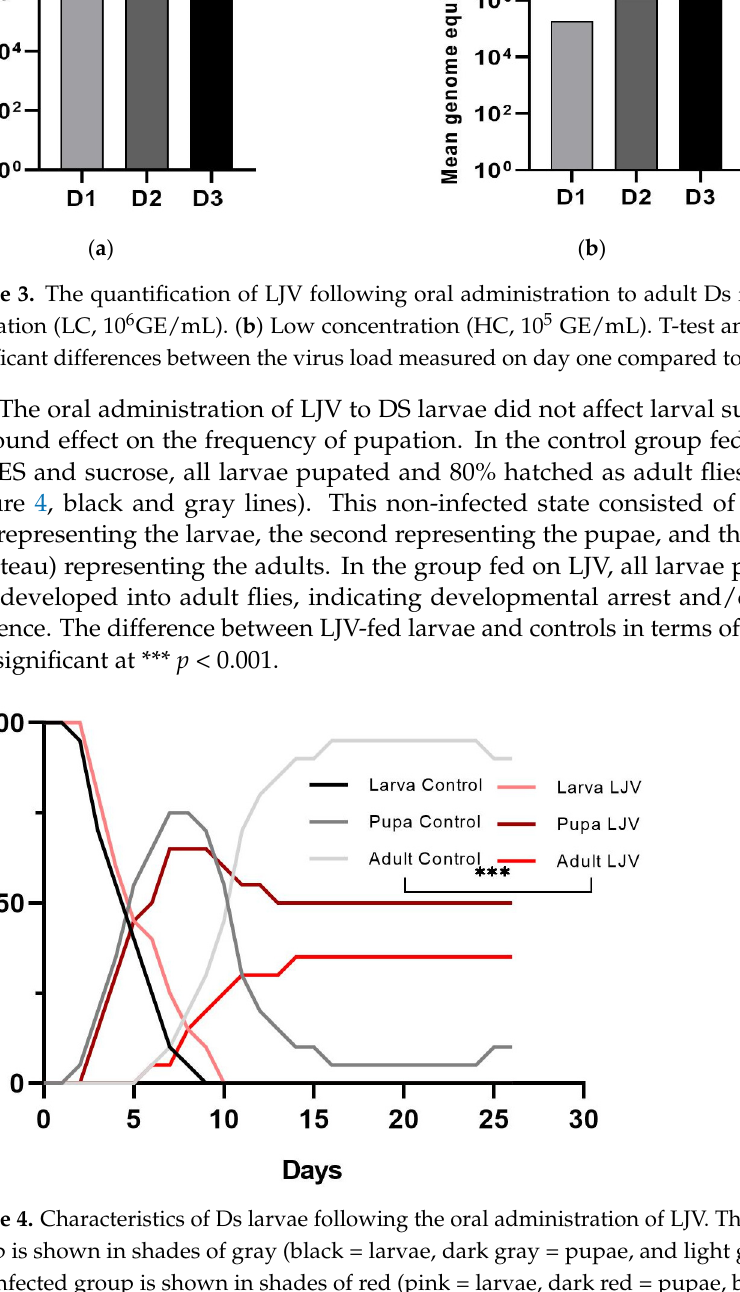
Figure 2. Survival of female Ds flies following the oral administration of LJV. Black line = untreated control, orange line = LJV low concentration (LC) of 10 5 GE/mL, and red line = LJV high concentra ‐ tion (HC) of 10 6 GE/mL. There was a significant difference in survival between LJV ‐ fed flies and the untreated control (**** p < 0.0001).